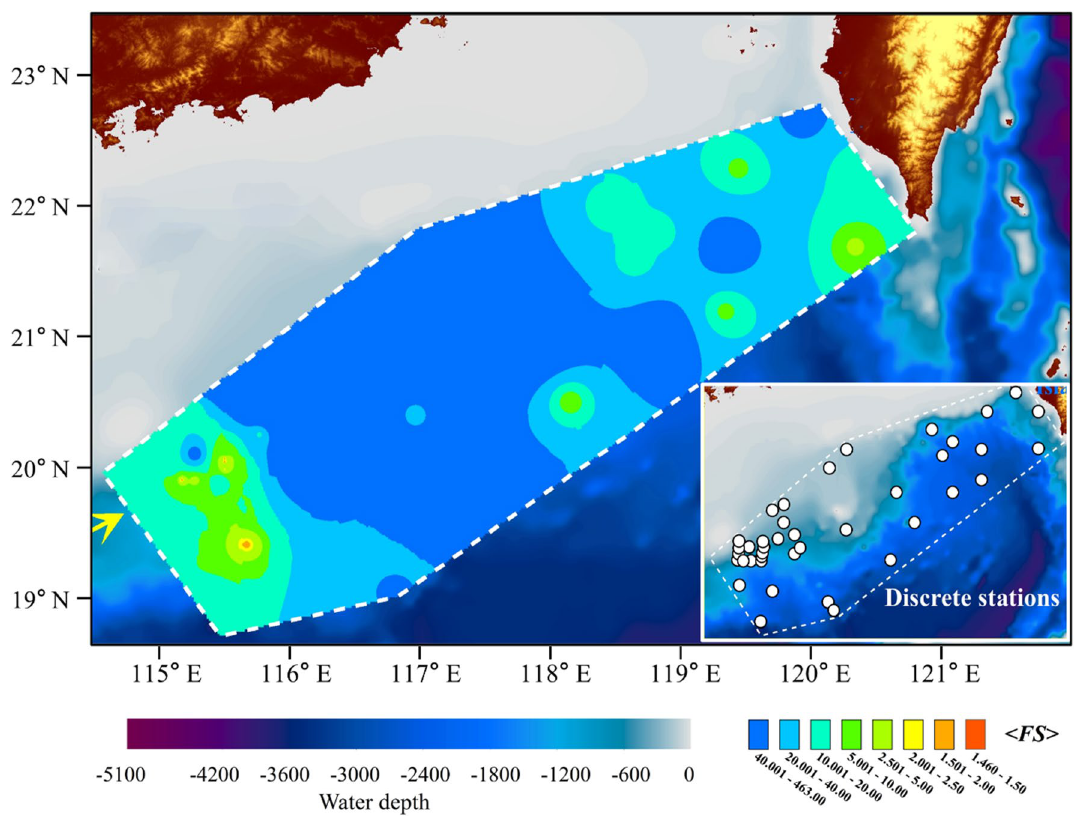
Fig. 21 Susceptibility map of submarine landslides on the northeast continental slope of the SCS. The map of known stations of physical and mechanical parameters and seismic distribution of marine sediment distributed on the continental slope of the northern SCS is shown in the lower right corner (modified from Nian et al.